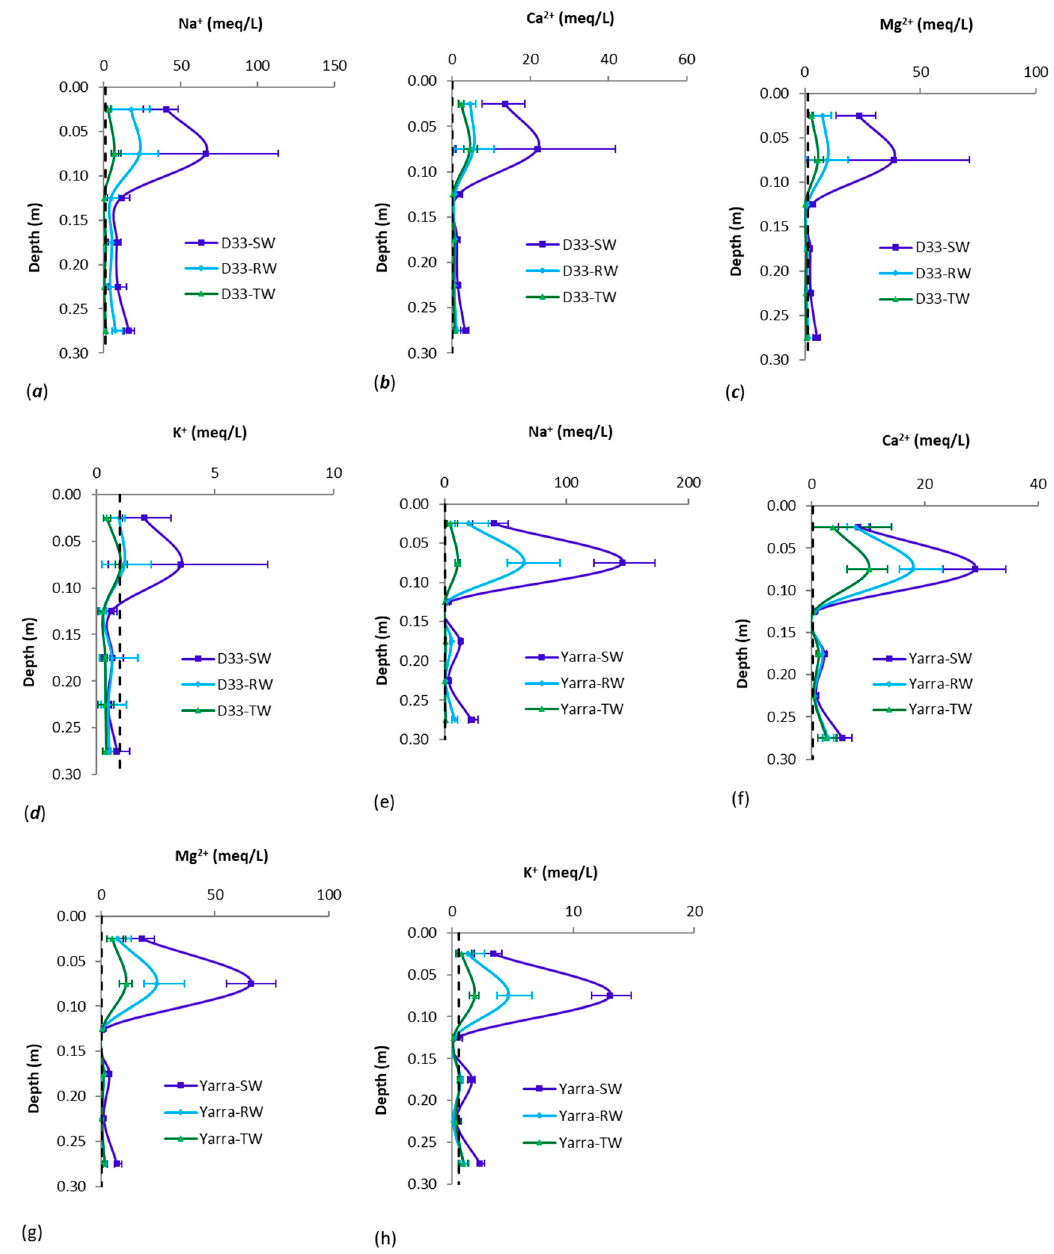
Figure 8. Salinity profile in terms of soluble cations ( a – d ) using TW, RW, and SW as irrigation water in D33 paddock ( a – d ) and Yarramundi ( e – h ) soil columns after the study period of 330 days. The dotted line and error bars show the initial value of cation, and the minimum and maximum values of measured cation, respectively.